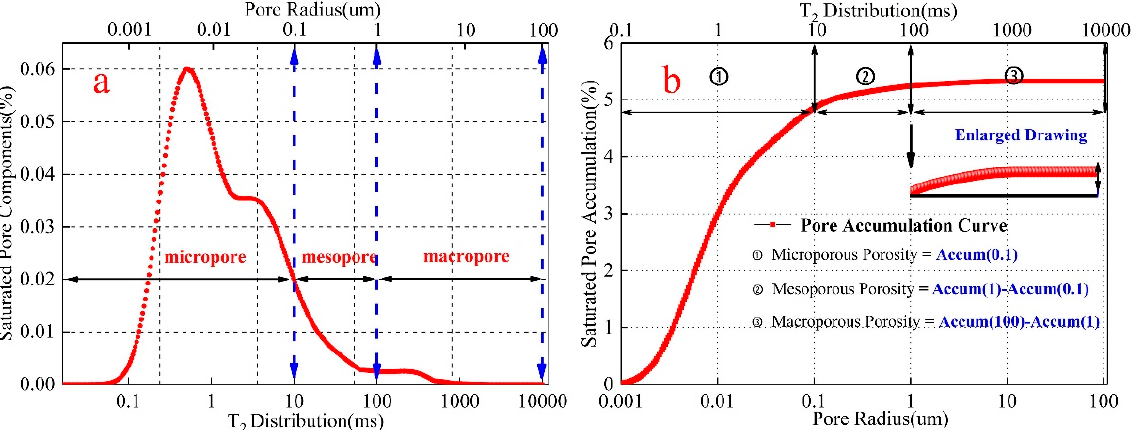
Figure 2. The pore size division of rock-like materials and the porosity division of different pore sizes. Figure ( a ) shows the pore division of different radii. Figure ( b ) shows the porosity division of different radii.